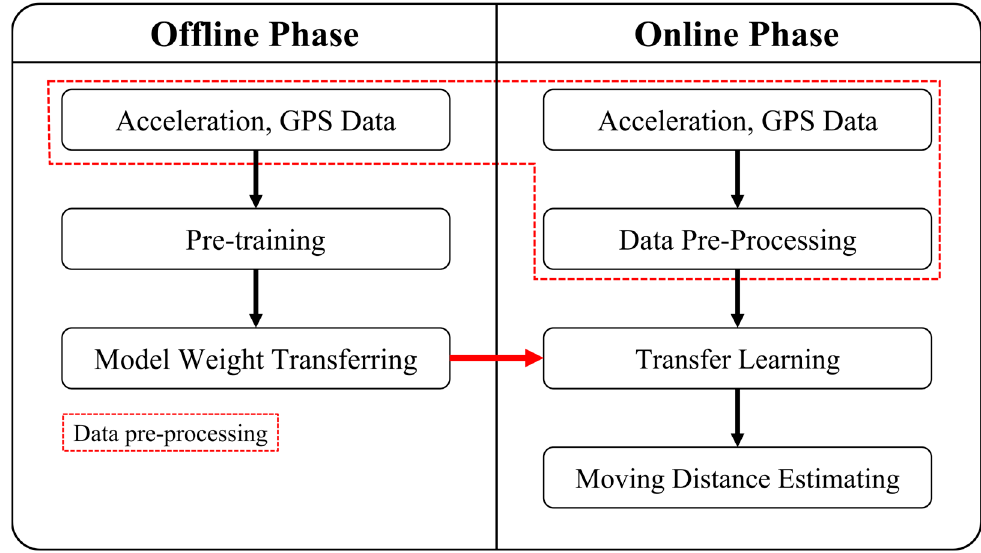
Figure 2. Moving object distance estimation system overview for the proposed system.